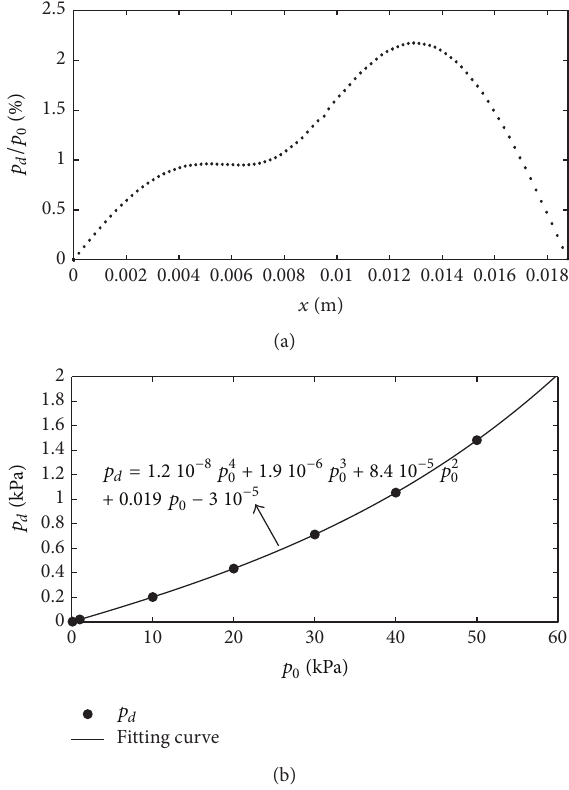
Figure 4: (a) Ratio of 𝑝 𝑑 to 𝑝 0 (%) versus distance from the source in the resonator and (b) maximal value of 𝑝 𝑑 in the resonator versus 𝑝 0 (in kPa). Bubble radius is 10 11 / m 3 , primary frequencies are 𝑓 and difference frequency is 𝑓 𝑑 = 20 kHz. Pressure amplitude at the source is 𝑝 0 = 20 kPa in (a) and is varied up to 50kPa in (b).